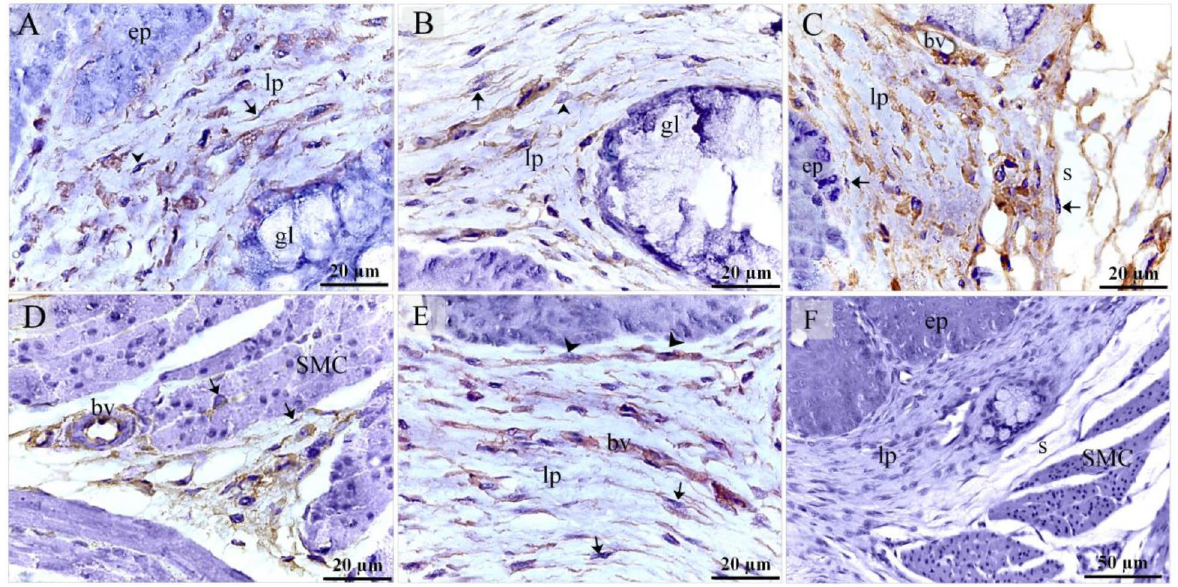
Figure 13. Immunohistochemical staining of the esophagus at day 15 using CD34. Immunostained paraffin sections for CD34. ( A , B ) Interstitial cells in the lamina propria (lp) were CD34-positive. CD34-positive TCs (arrows) were distinguished by cell prolongations (telopodes). CD34-positive fibroblast-like cells were detected. Note the epithelium (ep) and the gland (gl). ( C ) Numerous interstitial cells in the lamina propria (lp) were CD34-positive. Note the epithelium (ep), blood vessel (bv) and submucosa (s). CD34-positive TCs (arrows) were distinguished by cell prolongations (telopodes). ( D ) Peri-muscular tissue (pm) had strong affinity for CD34. CD34-positive TCs (arrows) were distinguished by cell prolongations (telopodes). Endothelial cells lined the blood vessel (bv) were CD34-positive. ( E ) Sprouting endothelial cells (arrowheads) located in lamina propria (LP). Note blood vessel (bv), CD34 positive TCs (arrows). ( F ) Negative control for CD34 immunostaining. Note epithelium (ep), lamina propria (lp), serosa (s), muscular layer (m).